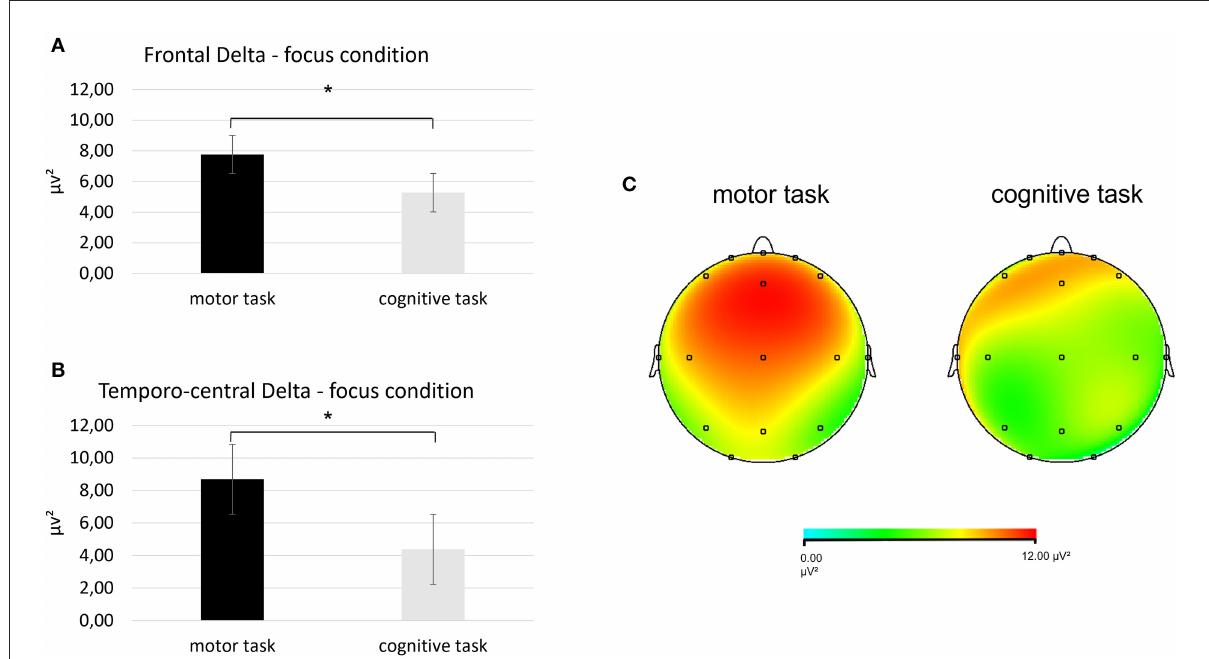
FIGURE3 Results for EEG delta band. (A) Bar chart showing frontal delta mean values in the focus condition during the two synchronization tasks. (B) Bar graph displaying the significant increase in temporo-central delta values in the focus condition when performing the two synchronization tasks. (C) Red area represents greater delta power in the focus condition during the motor (left head) than the cognitive task (left head). For all charts, bars indicate ± 1 standard error (SE); all asterisks mark statistically significant differences, with p ≤